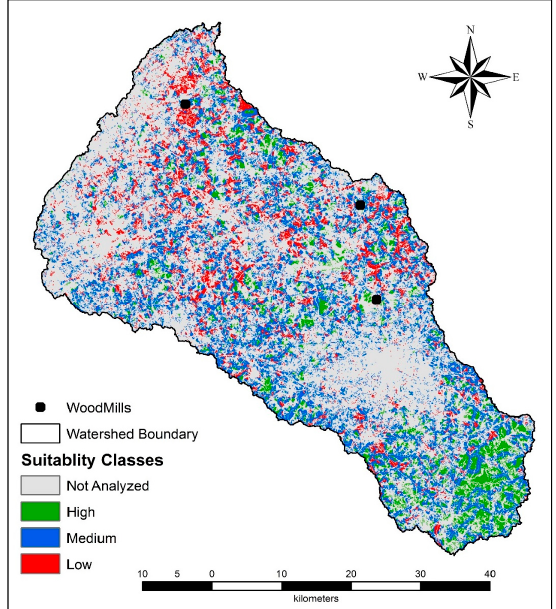
Figure 4. Suitability map of loblolly pine for selected watershed for selected land covers (evergreen forest, shrubland, grassland, and pasture/hay). Table 5. Distribution of suitability classes under pasture/hay, grassland, shrubland, and evergreen forest.